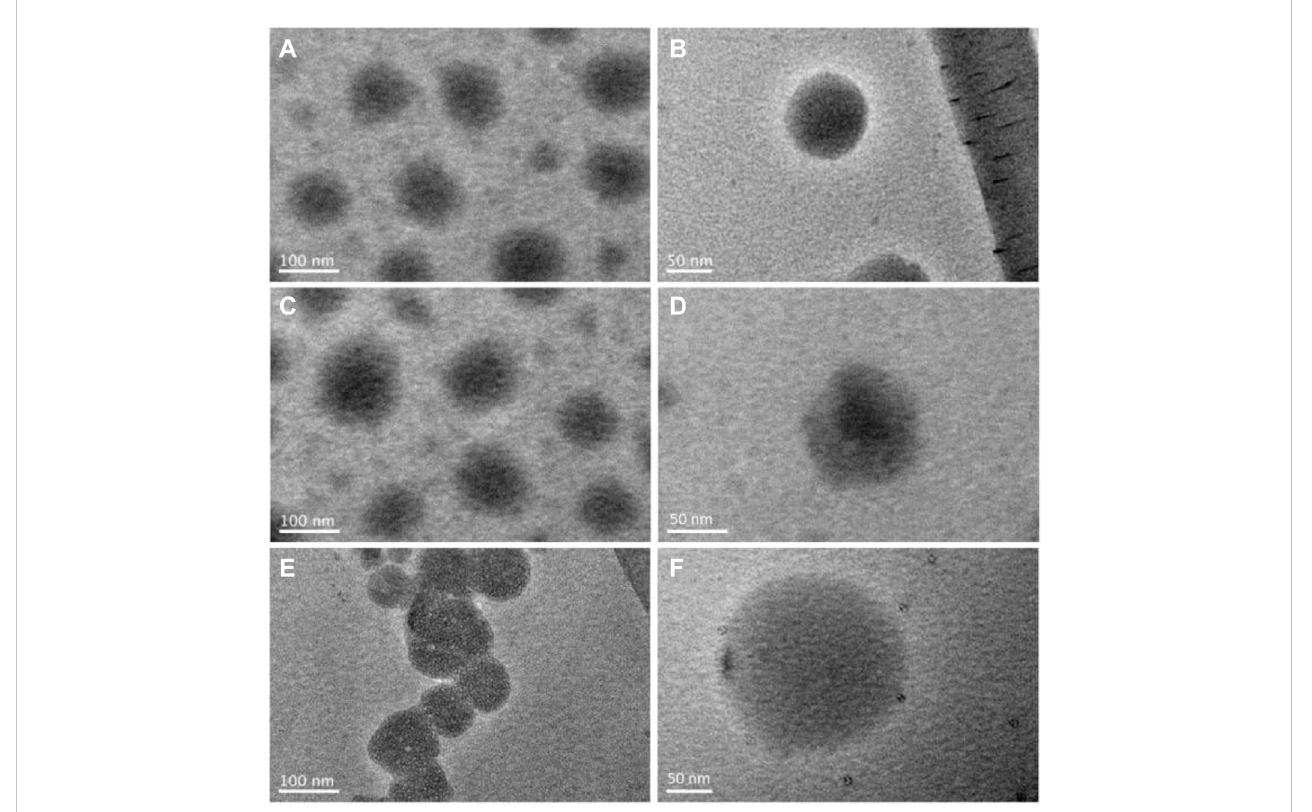
FIGURE 6 TEM images of the lipid particles suspended in the self-emulsi fi ed liquids: (A) and (B) S1, (C) and (D) S2, (E) and (F)